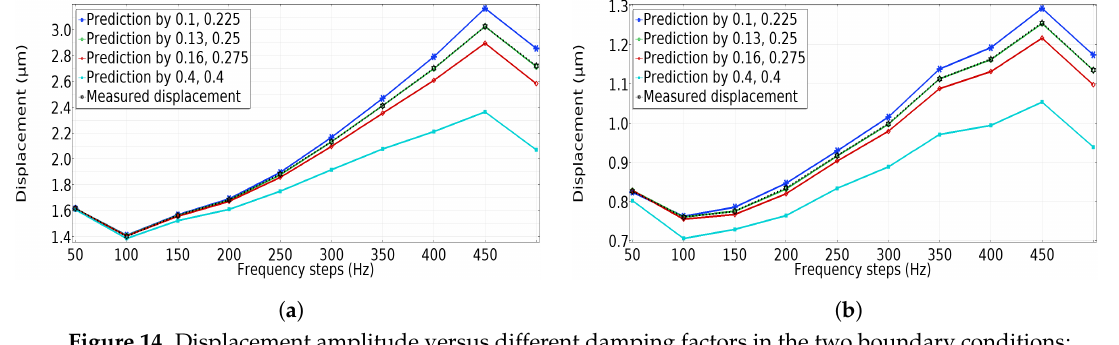
Figure 14. Displacement amplitude versus different damping factors in the two boundary conditions; 0.1 to 0.4 were varied in the ( f 1 ) and 0.225 to 0.4 were varied in the ( f 2 ) ; ( a ) connected pipette; ( b ) pipette with gap.